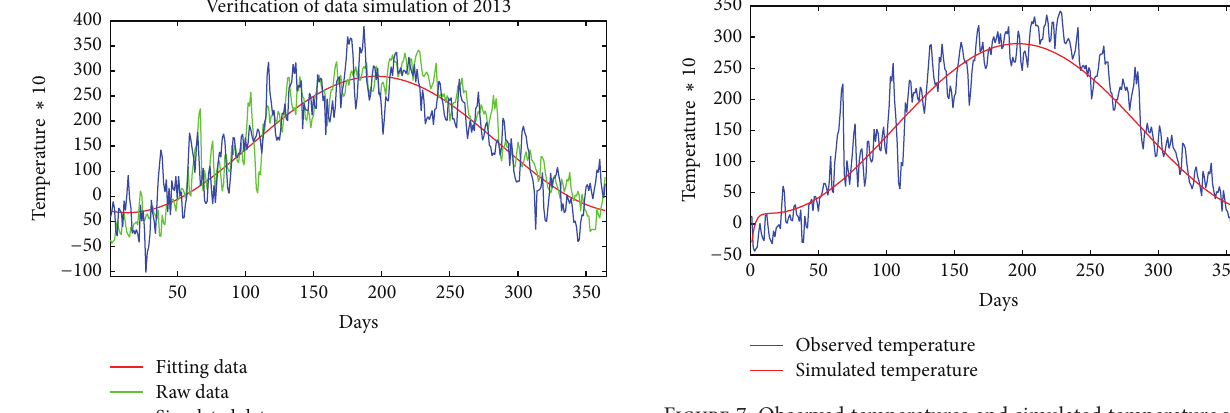
Figure 7: Observed temperatures and simulated temperature with 100,000 simulations (Zhengzhou, 2013). Table 3: Performance of the mean-reverting Ornstein-Uhlenbeck process for modeling daily temperature in